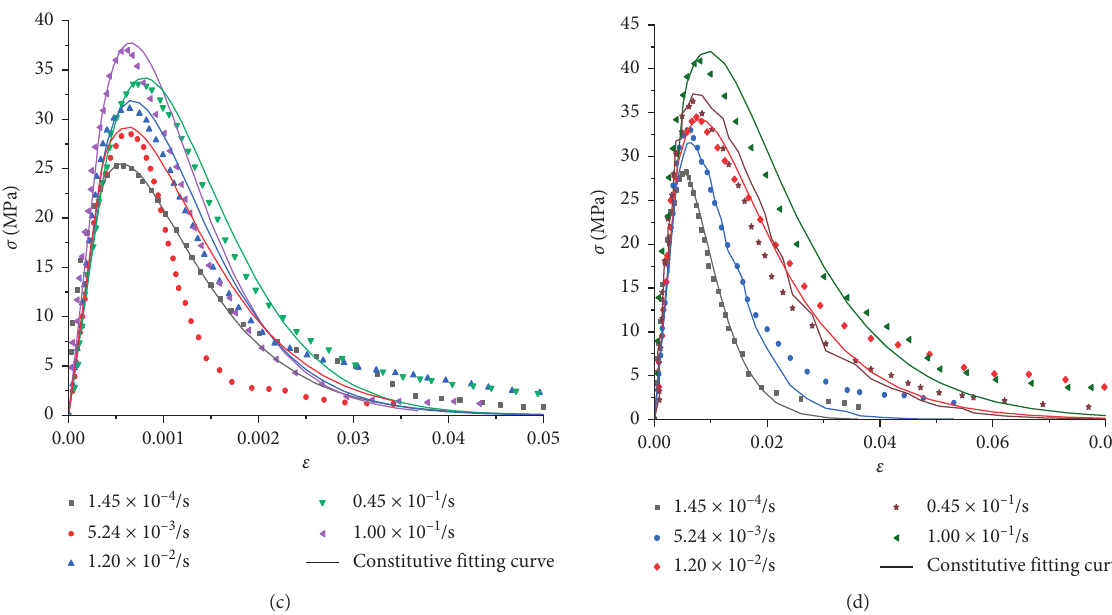
Figure 14: Constitutive fitting of SFRC at different strain rates. (a) V